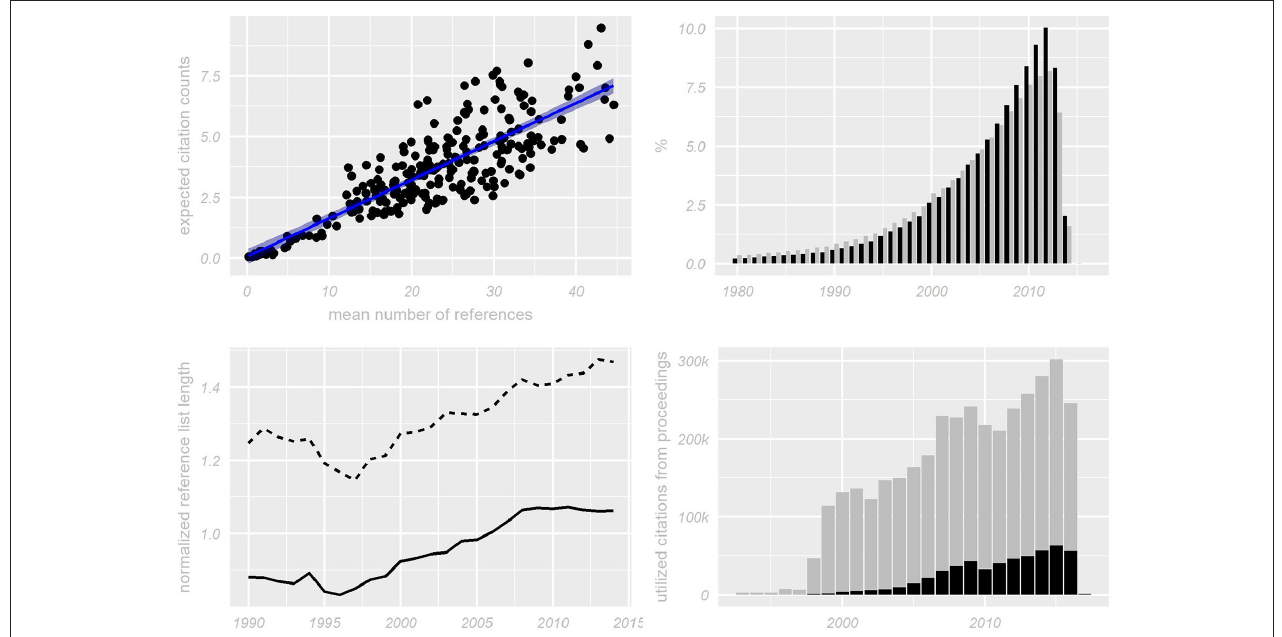
FIGURE 3 | (Upper left panel) Scatterplot of Subject Categories concerning their average reference list length and expected citation counts in 2014; (Lower left panel) normalized length of Chinese reference lists (solid line) and normalized length of Chinese reference lists utilized in citation window (dashed line); (Upper right panel) distribution of cited article over time from citing articles from 2014; (Lower right panel) stacked yearly count of utilized citations from non-standard document types. Besides upper left panel Chinese values are depicted in black, while gray values denote the sample-based, non-Chinese equivalents.